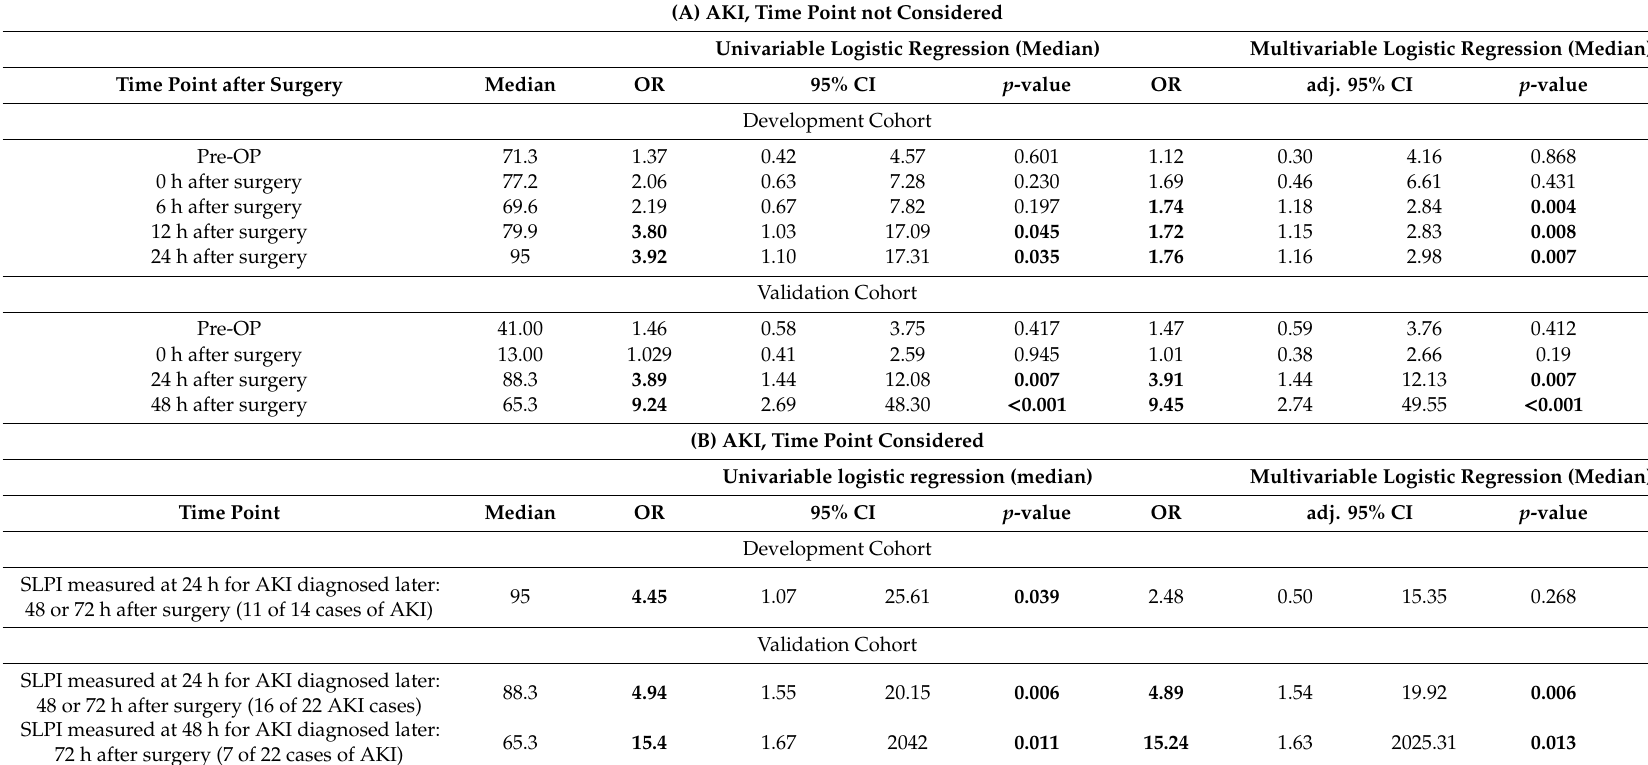
Table 5. SLPI as a predictor of AKI. (A) Univariable logistic regression. Serum SLPI was a significant predictor of AKI 12, 24, and 48 h after surgery. Multivariable logistic regression adjusted for Cleveland Clinic Foundation Score (including the variables sex, congestive heart disease, left ventricular ejection fraction, use of intra-aortic balloon-pump, chronic obstructive pulmonary disease, insulin-requiring diabetes, previous heart surgery, emergency surgery, type of surgery, and preoperative serum creatinine). After adjustment for the Cleveland Clinic Foundation Score, serum SLPI remained a significant predictor of AKI. (B) Subgroup analysis of cases of AKI that were diagnosed after the respective SLPI measurement. For SLPI measured at 24 h, only the cases of AKI that were diagnosed at 48 or 72 h ( n = 11 in the DC and n = 16 in the VC) were considered. For SLPI measured at 48 h, only the cases of AKI that were diagnosed at 72 h after surgery were considered. SLPI was categorized by the corresponding median; CI, confidence interval; OR, odds ratio; Pre-OP, before surgery; SLPI, secretory leukocyte protease inhibitor; bold fonts indicate p -values < 0.05.